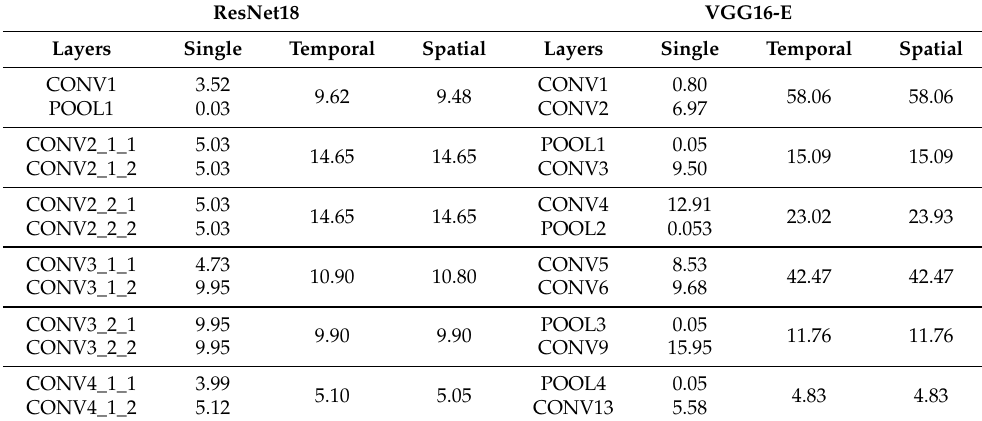
Table 7. CTC ratios for ResNet18 and VGG16-E for the single- and inter-layer schedules of Figures 14 and 15. For single-layer the CTC ratios are reported for each layer, whereas for spatial and temporal fusion the CTC ratios of the fused sequences of layers are reported. ResNet18 VGG16-E Layers Single Temporal Spatial Layers Single